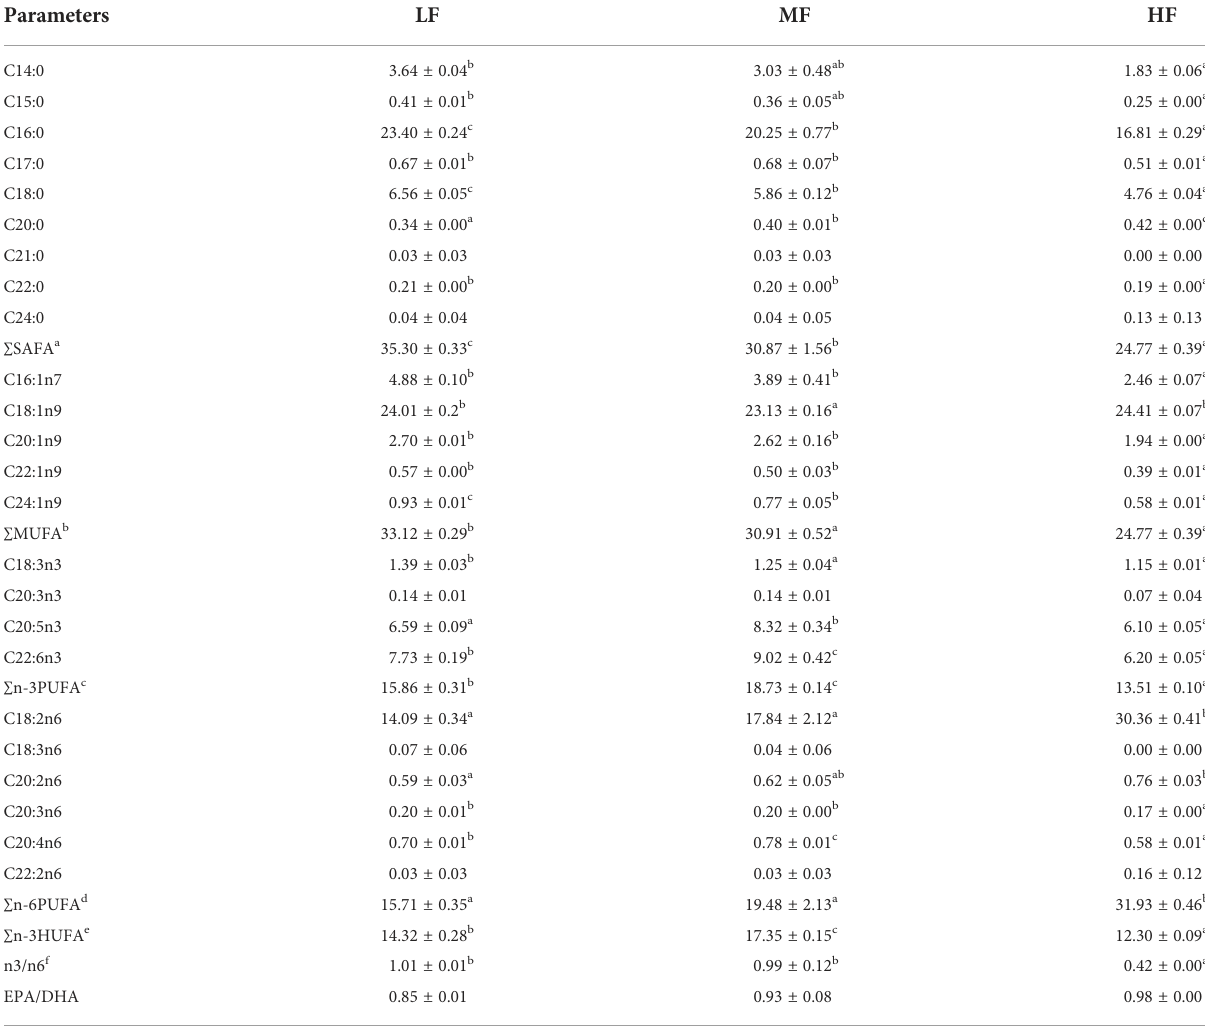
TABLE 6 Effect of dietary lipid levels on fatty acid composition of whole-body in hybrid grouper (% total fatty acids). Parameters